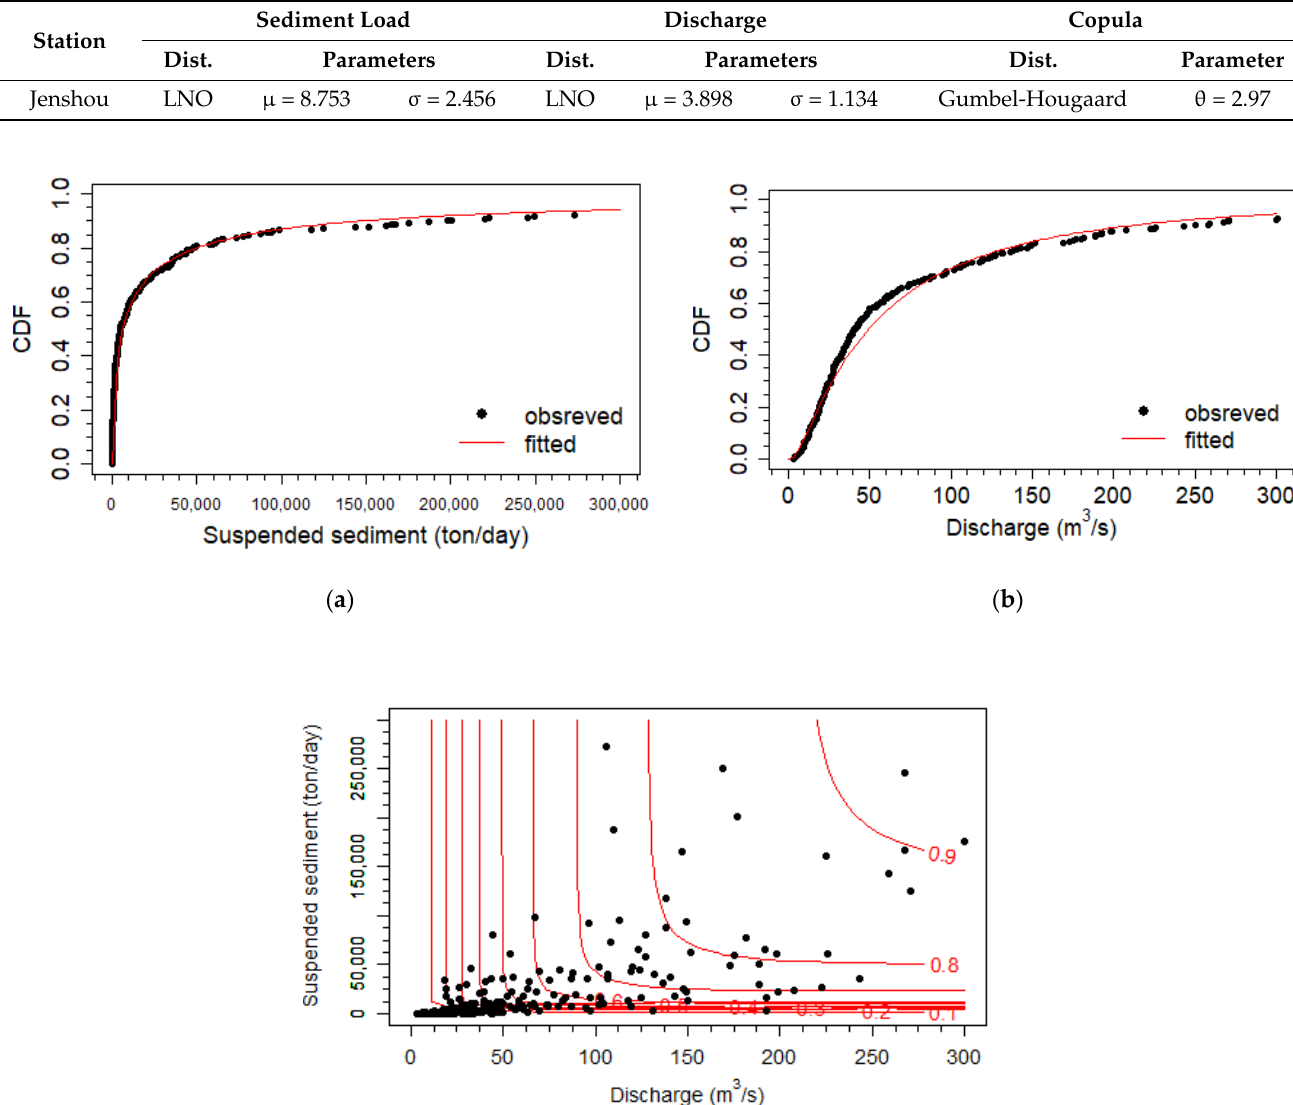
Table 3. The best-fitted marginal distributions and copula for suspended sediment load and discharge.